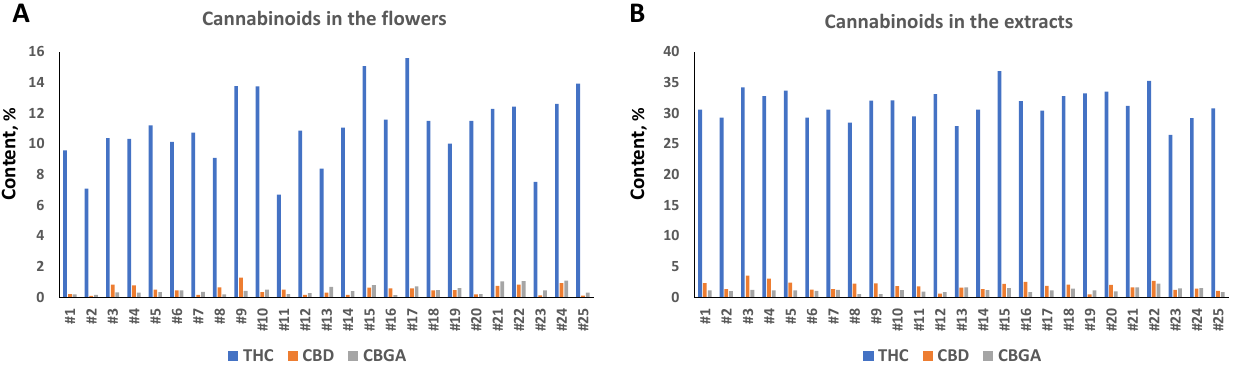
Figure 1. Total THC, CBD and CBG content in the flowers ( A ) and extracts ( B ). Concentration is shown in the percentage of total weight of dry flowers or extracts prepared from flowers of 25 varieties.